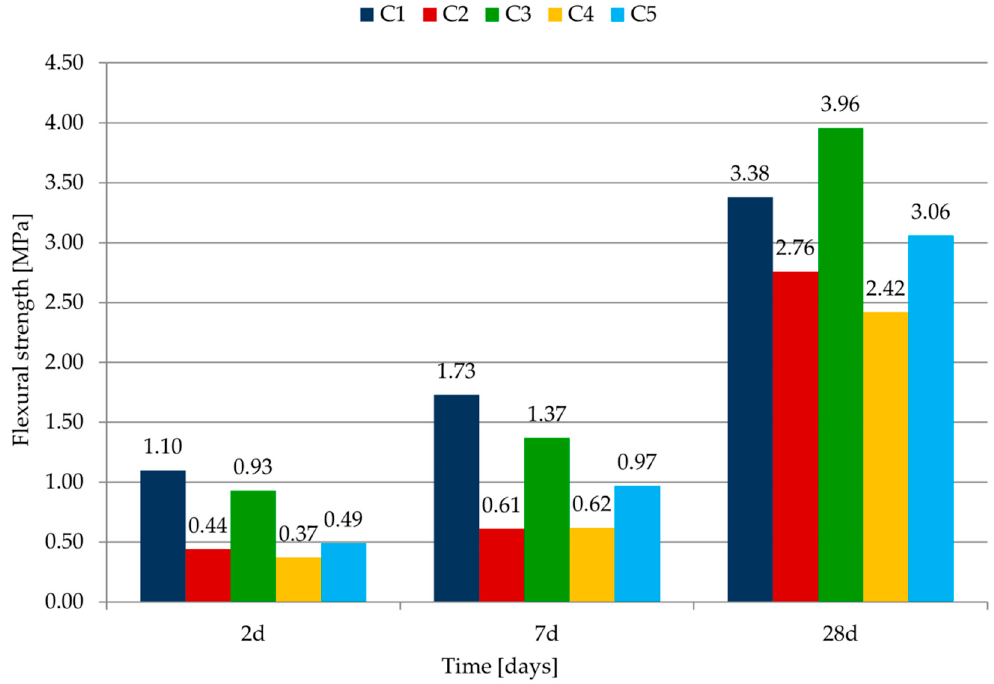
Figure 5. Change of flexural strength after different curing times.